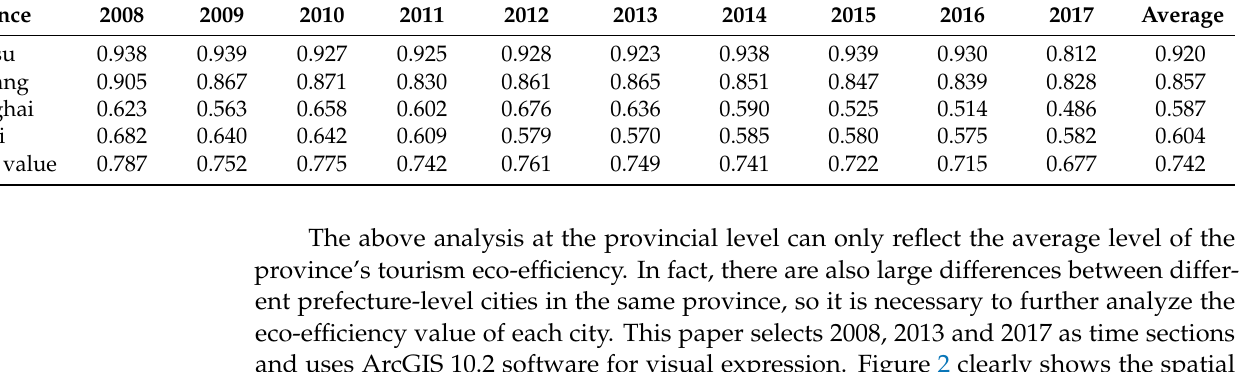
Table 2. Provincial tourism eco-efficiency in the Yangtze River Delta urban agglomeration from 2008 to 2017.